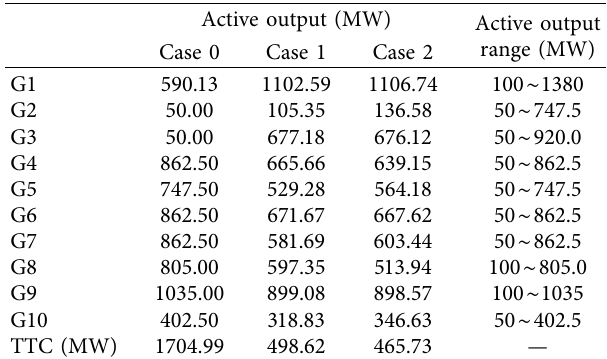
Figure 2: The regional division of the IEEE 39-bus Table 1: Active output of generators and TTC in IEEE 39-bus system.